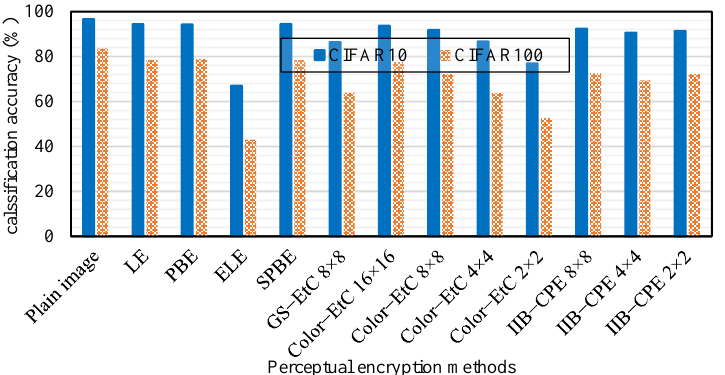
Figure 11. Classification accuracy (%) of the deep learning model in the encryption domain on CIFAR10 and CIFAR100 datasets.